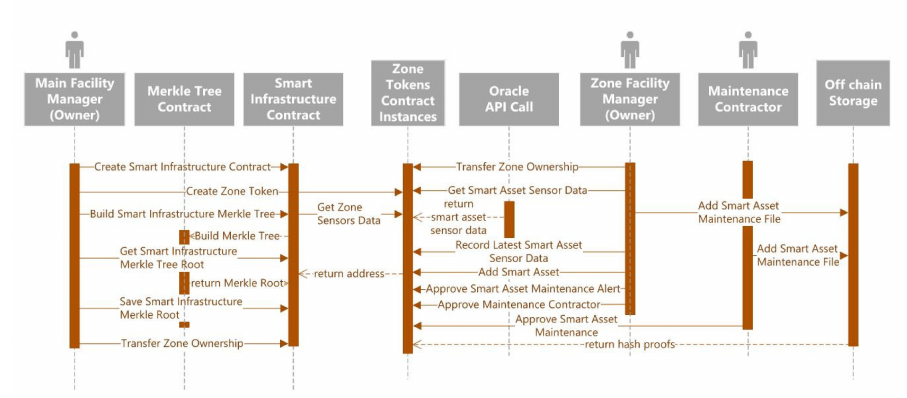
Figure 3. Sequence diagram of the BCDT 6D smart contract.